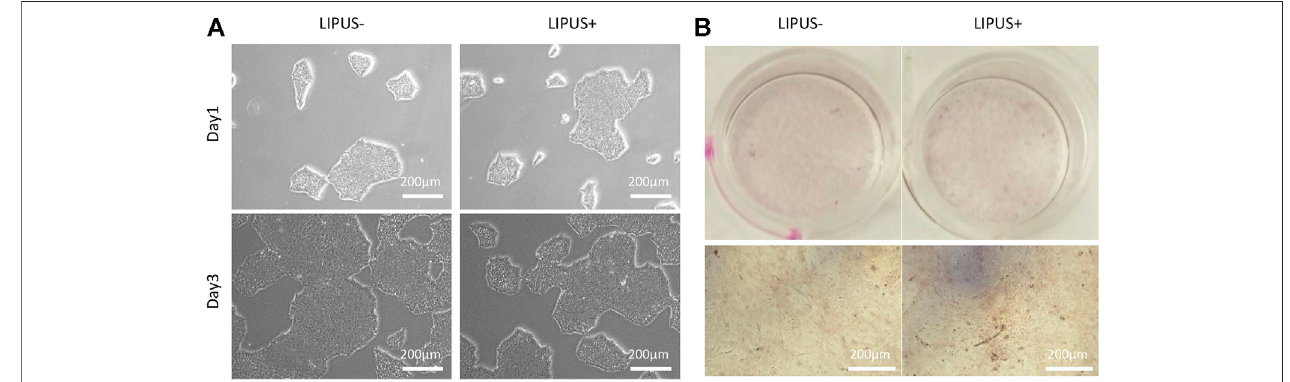
FIGURE6| EffectsofLIPUS40/50onEB-MSCdifferentiationanddirectosteogenicdifferentiationofEBcells. (A) MigrationofMSC-likecellsfromEBswith/without LIPUS40/50 on days 0, 2, 6, and 8. (B) Phenotype of P2 iMSCs produced from EBs with/without LIPUS40/50. CD29, CD105, CD44, and CD73 were typical mesenchymal positive markers. (C) Alizarin Red staining of dissociated EB cells cultured in the ODM with/without LIPUS40/50.